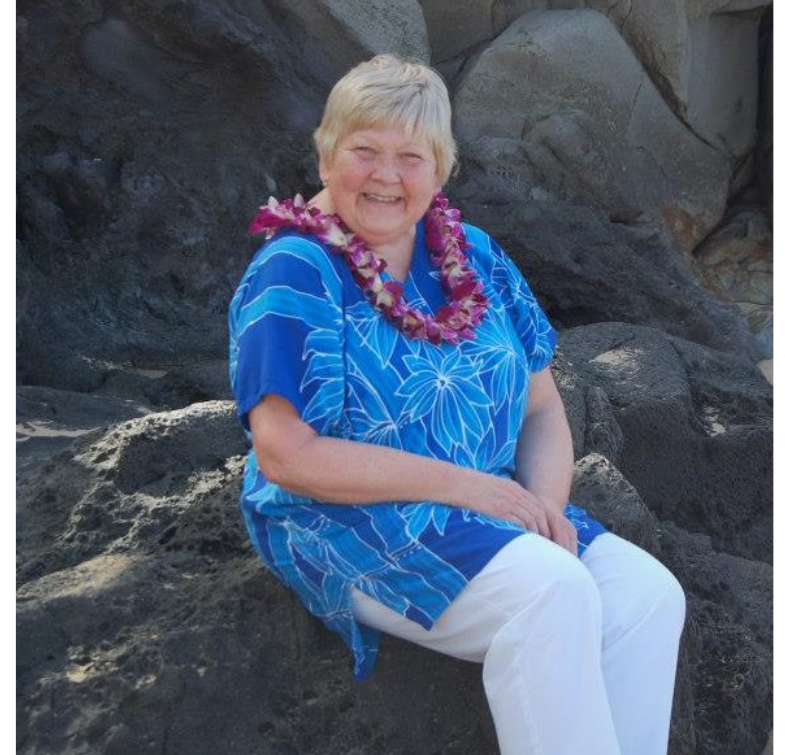
Figure 1. Photo of Judi Tuerck (submitted by her family).